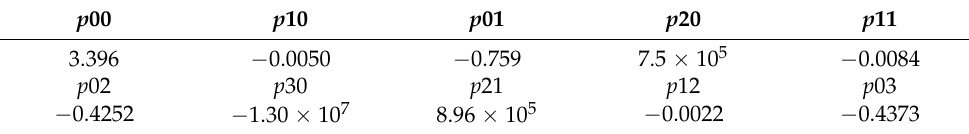
Table 1. Values of the coefficients in the OCV- SOC - T function.